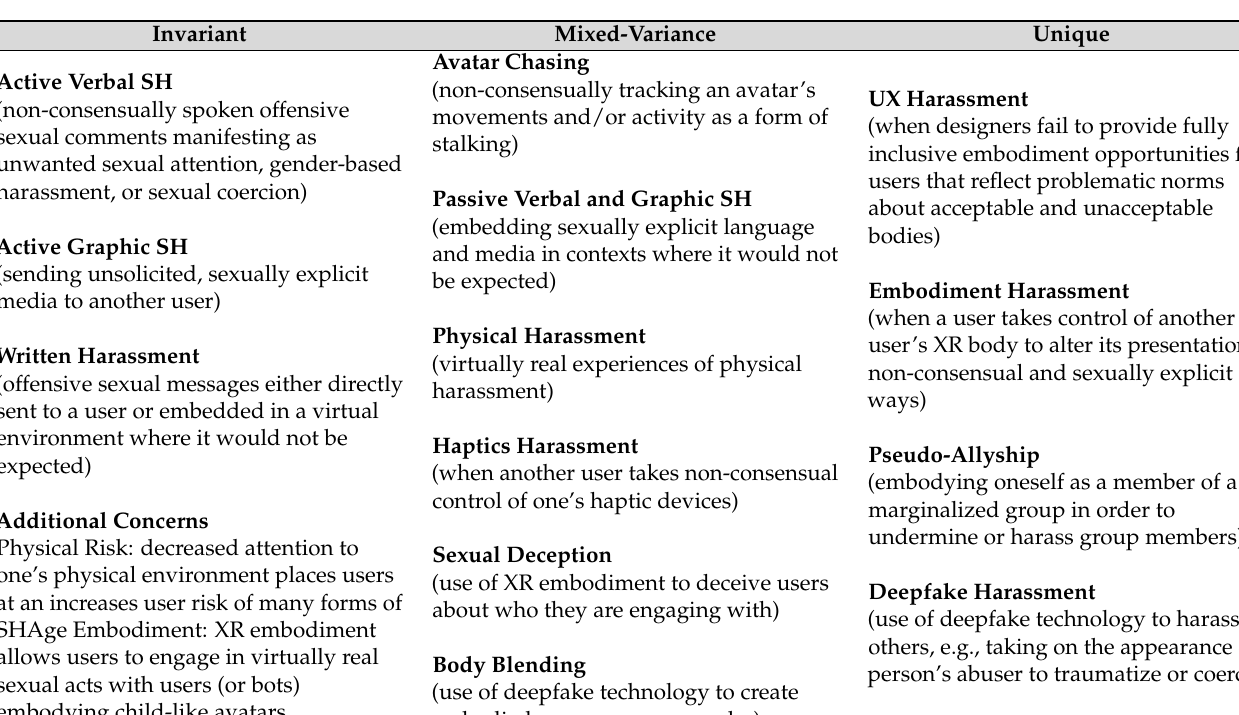
Table 3. Varieties of and vehicles for Sexual Harassment in social XR